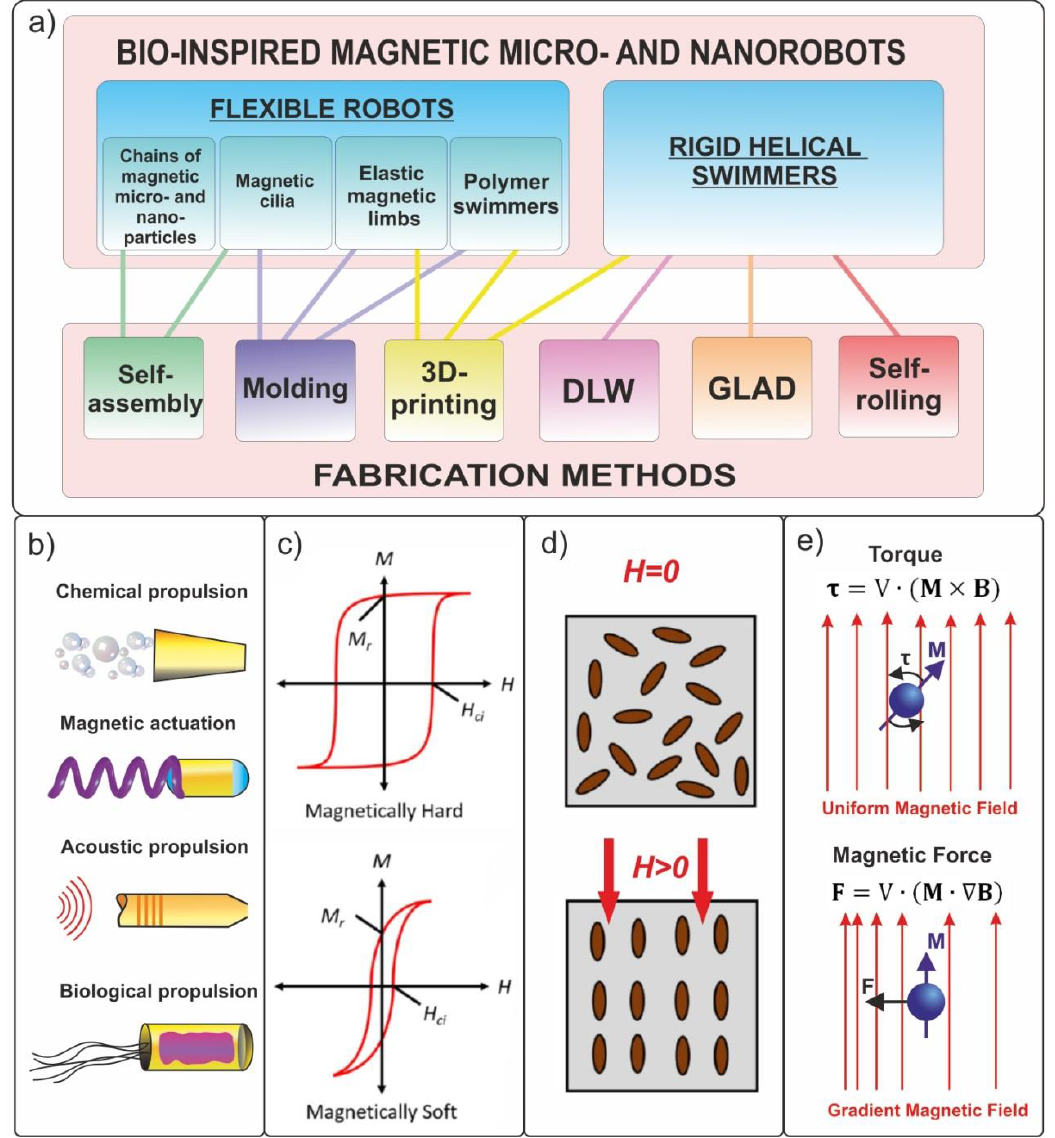
Figure 1. ( a ) Approaches to the fabrication and control of magnetic microrobots. ( b ) Methods for actuating biomimetic micro- and nanorobots. ( c ) Dependence of magnetization on the external magnetic field for hard and soft magnetics. ( d ) Schematic representation of a polymer with magnetic particles cured without and in the presence of a magnetic field. Reproduced from [24]. CC BY 4.0. ( e ) Movement of magnetic object in a uniform and non-uniform magnetic field.